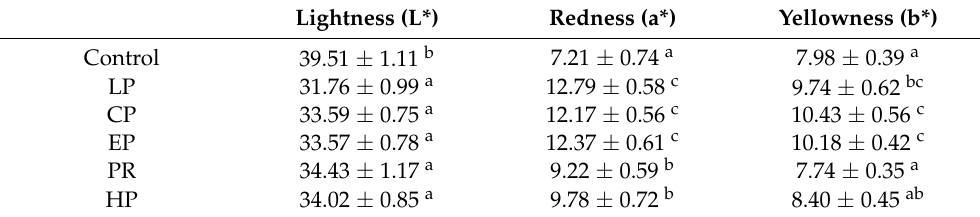
Table 3. The color parameters of dorsal muscle in Oncorhynchus mykiss fed experimental diets.